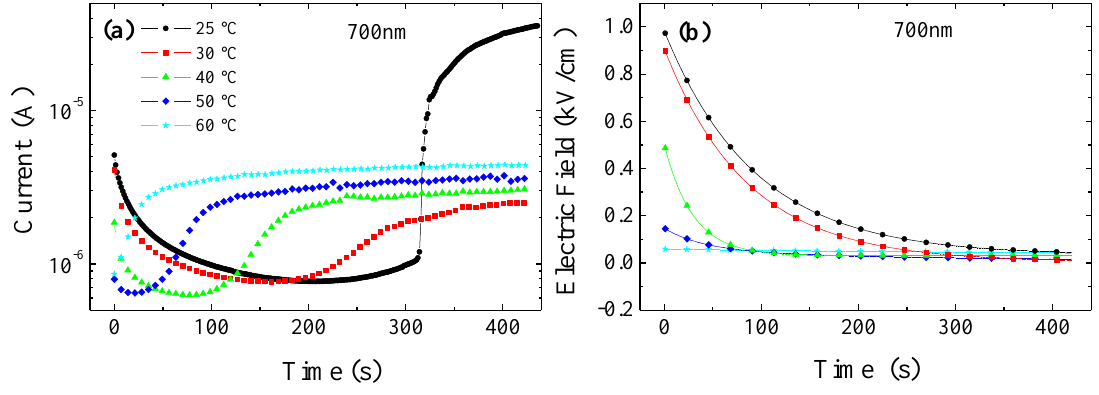
Figure 9. Transients at 600V, at different temperatures, for optical irradiation at 700 nm on the cathode side: ( a ) Current transients; ( b ) Electric field transients at 60 µm from the